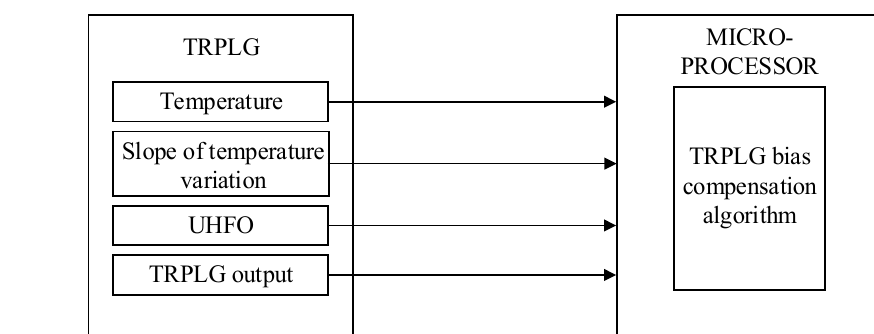
Figure 4. The hardware structure of TRPLG bias compensation.